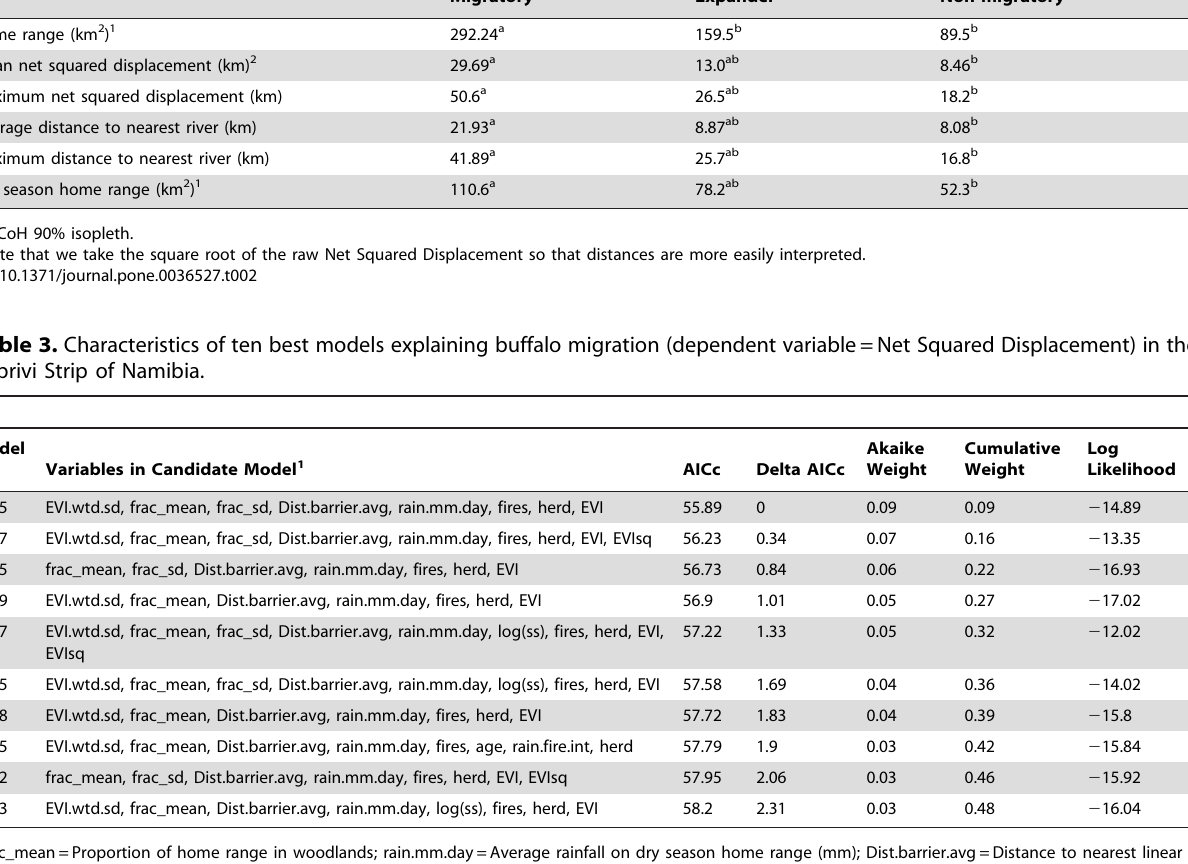
Figure 2. Examples of seasonal movement types displayed by adult buffalo in the Caprivi region of Namibia. (a) migrant; (b) non- migrant; (c) expander; (d) disperser.